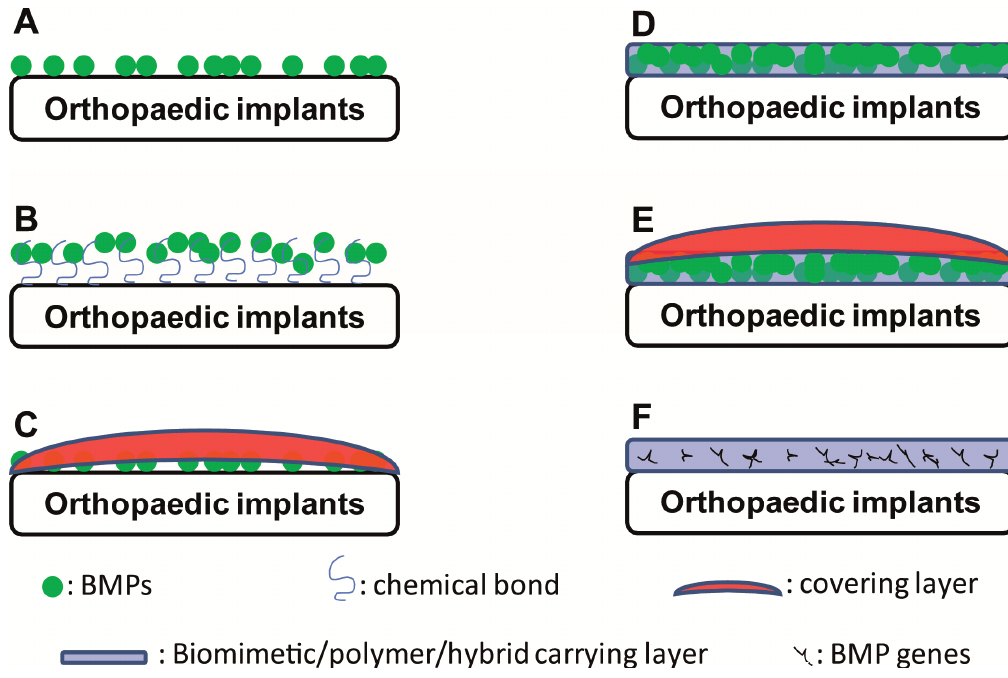
Figure 2. Schematic illustrating the types of BMP/BMP-functionalised coatings on orthopaedic implants. ( A ) Direct adsorption; ( B ) Immobilisation of BMP through a chemical bond; ( C ) Adsorption of BMPs with a covering/barrier layer; ( D ) Incorporation of BMPs into a biomimetic/polymer/hybrid carrying layer; ( E ) Incorporation of BMPs into a polymer/hybrid carrier layer in combination with a covering/barrier layer; and ( F ) Incorporation of BMP genes into a polymer/hybrid carrier